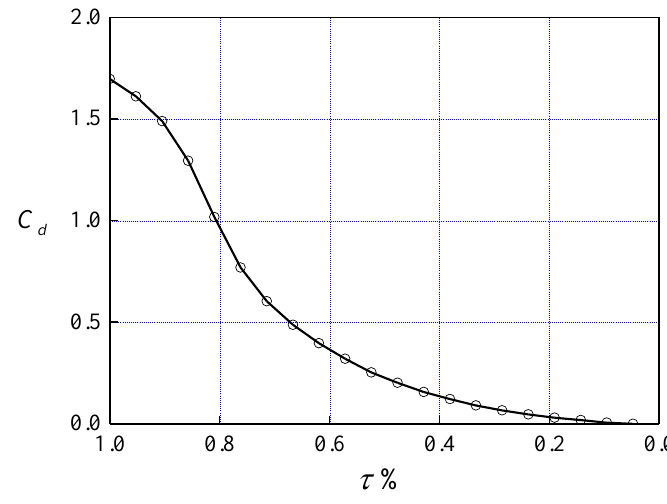
Figure 2. Discharge coefficient and open ratio.